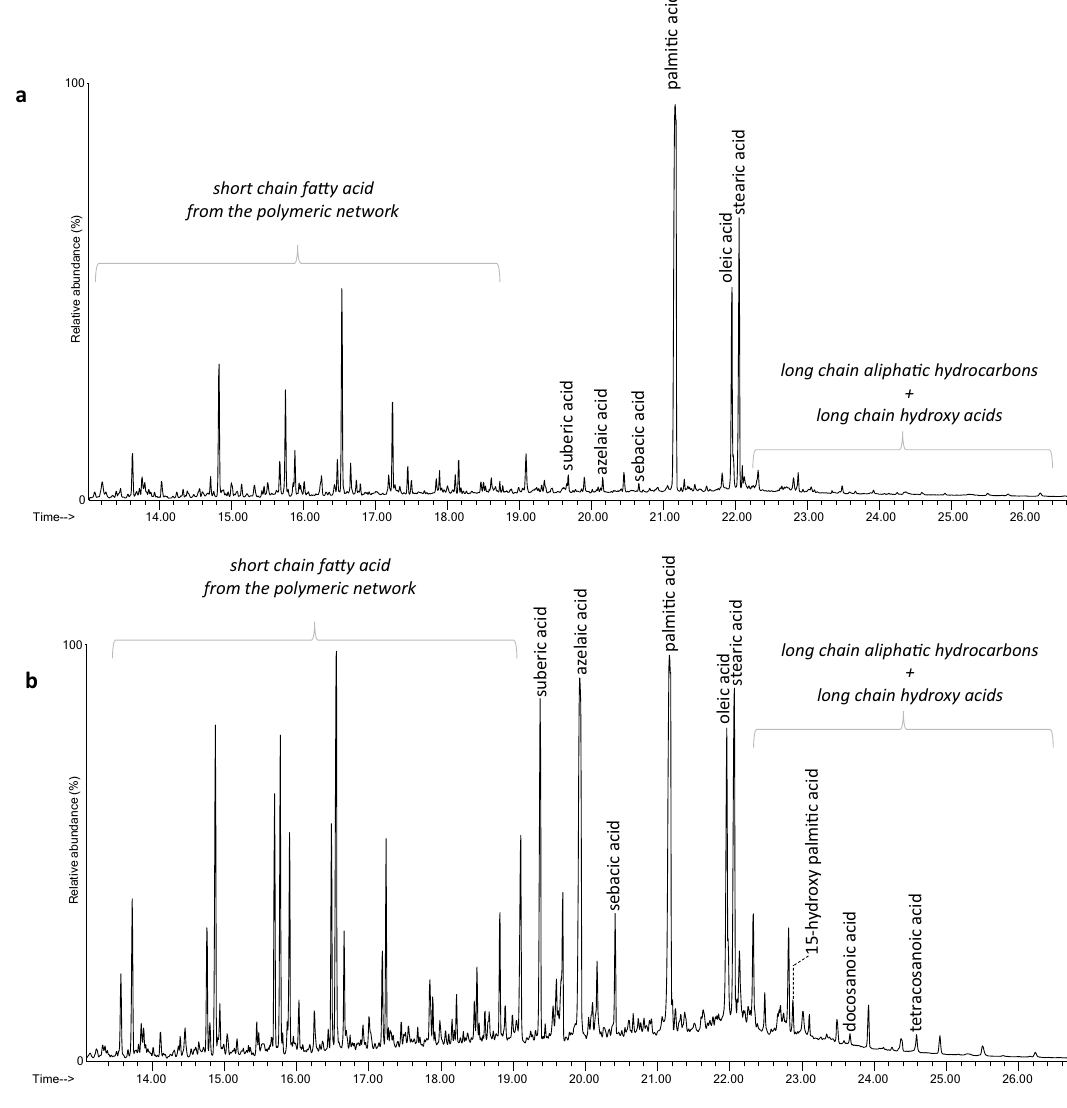
Figure 5. Py(HMDS)-GC–MS chromatograms obtained for a sample collected from crayon DS37 (a) and one from crayon DS34 (b)